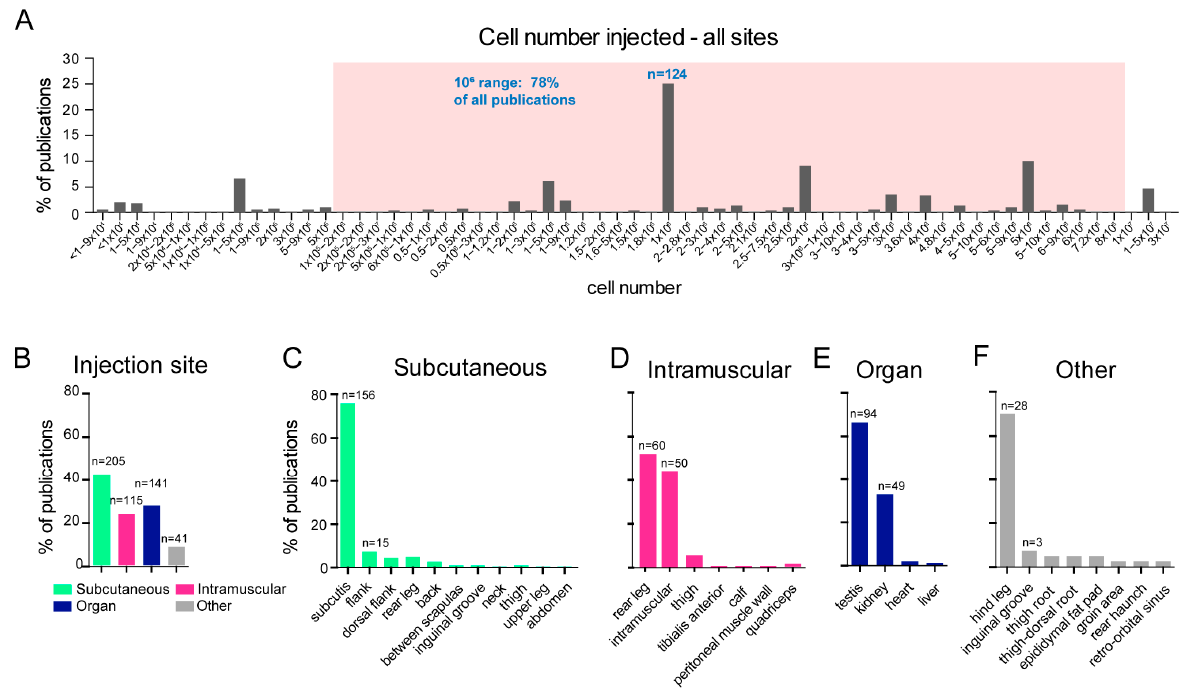
Figure 3. Overview of number of injected cells and anatomical injection site. ( A ) Distribution of injected cell numbers. In case surface area and confluency were reported rather than cell number, cell number was recalculated; 1 × 10 6 represent the most frequent number of injected cells (25.2%, n = 124). The red box includes all cell numbers within the 1 × 10 6 range. ( B ) Most commonly used anatomic areas for cell injection (subcutaneous, intramuscular, organs, other). Note that percentages do not sum up to 100% due to various reports where the assay was performed in multiple injection sites. ( C – F ) Reported and described anatomical sites for injection.